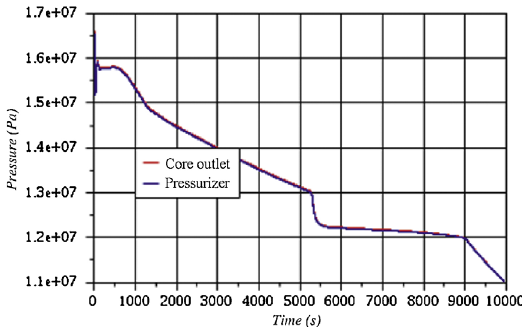
Fig. 12. Primary pressure (Pa).